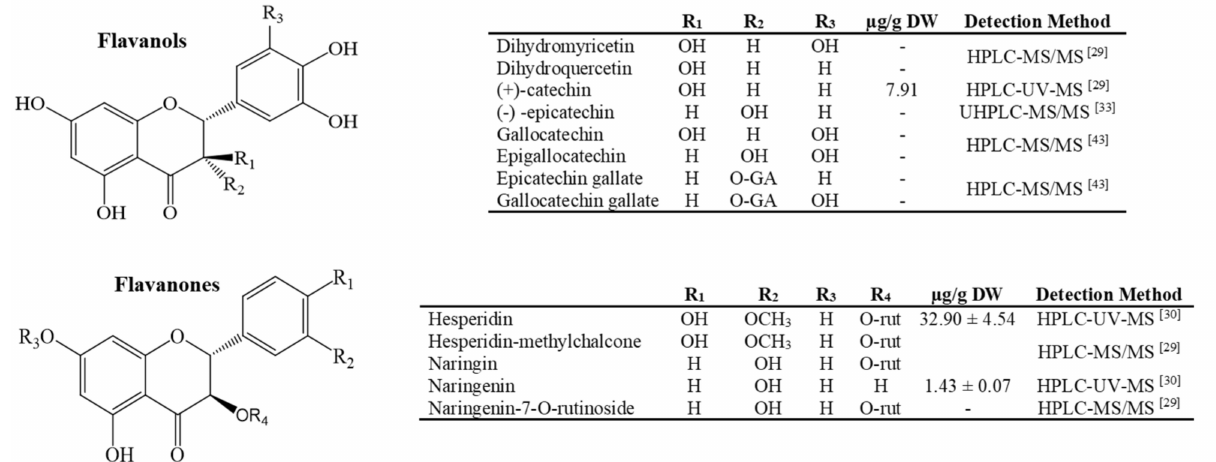
Figure 1. Current phenolic acids and flavonoids identified and quantified in the Agave genus, CA = cafeic acid, GA = gallic acid, rut = rutinoside, glc = glucoside, QA: quinic acid, DHLA= 3,4-dihydroxiphenillactic acid [29,30,33,43,52–54].